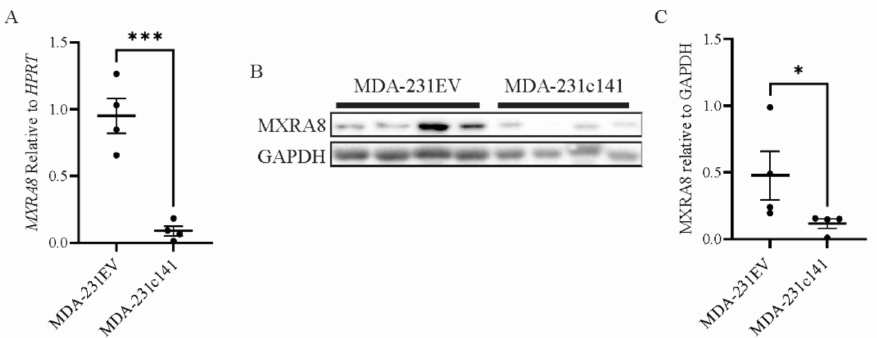
Figure 5. The expression of ( A ) MXRA8 mRNA levels as determined by qRT-PCR and ( B , C ) MXRA8 protein levels as determined by Western blotting. MXRA8 mRNA levels were normalized to HPRT, while MXRA8 protein levels were normalized using GAPDH. ( C ) Quantitation of the MXRA8 band intensities from the Western blot relative to the GAPDH band intensities. In both A and C , the individual values have been indicated along with the mean ± SEM. A Student’s t -test was performed and significance is indicated as * p < 0.05; *** p < 0.001.